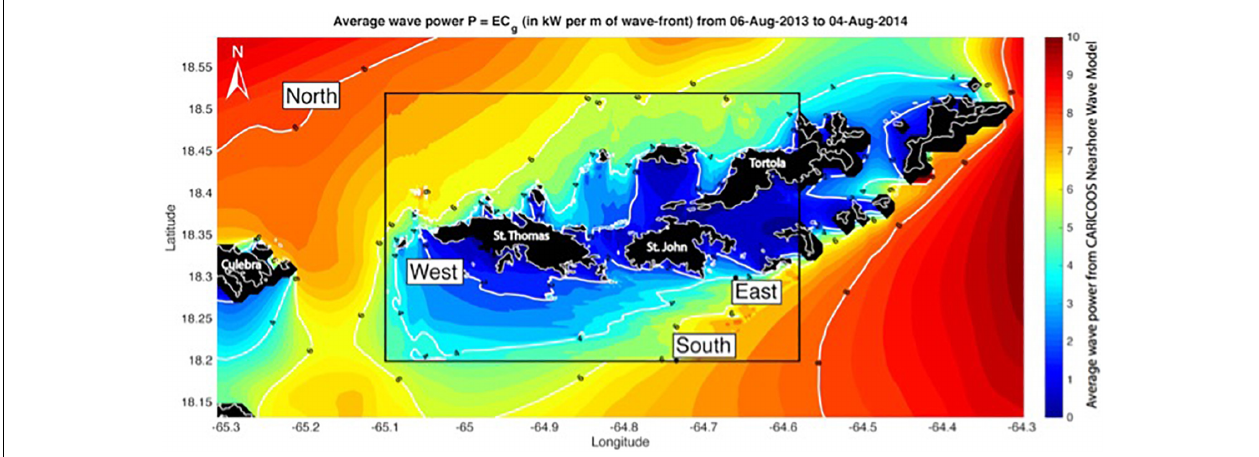
FIGURE 5 | Average wave power per unit wave crest in the United States Virgin Islands computed using model output from the CARICOOS Nearshore Wave Model. Site locations are within the white boxes (Loeffler et al., 2018).